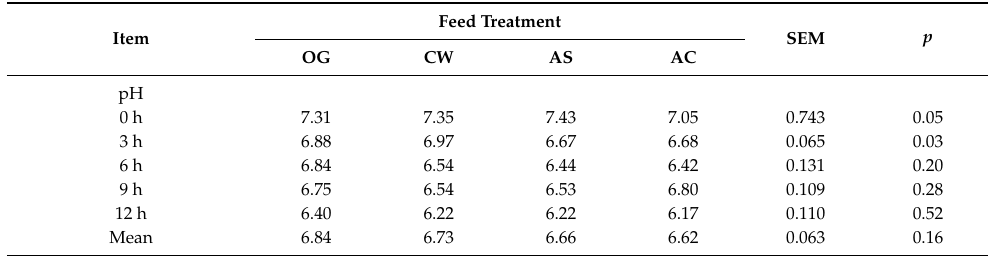
Table 7. Effects of dietary treatment on pH, NH 3 -N and VFA concentration at five time points in lactating cows 4